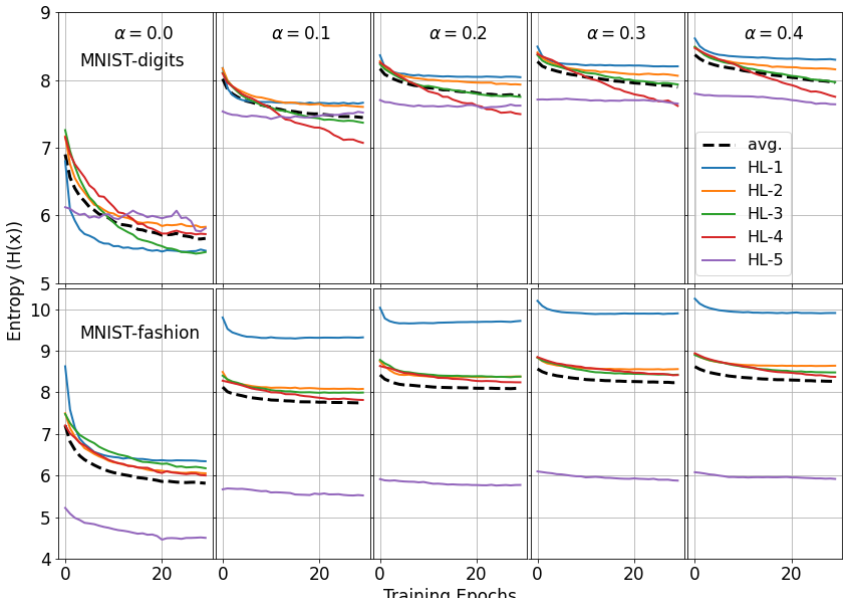
Figure 5. Entropy profile for the 5-layer neural network during the training process. Linearity factor ( α ) in L-ReLU was changed from α = 0.0 to α = 0.4. Hidden layers 1–5 of the neural network consist of nodes combinations: 256, 128, 128, 128 and 32, respectively. This test was done using two different data sets, 60,000 MNIST-digits images ( upper panel ) and MNIST-fashion images ( lower panel ) with 33% validation split. Black curves show the average (avg.) entropy in the